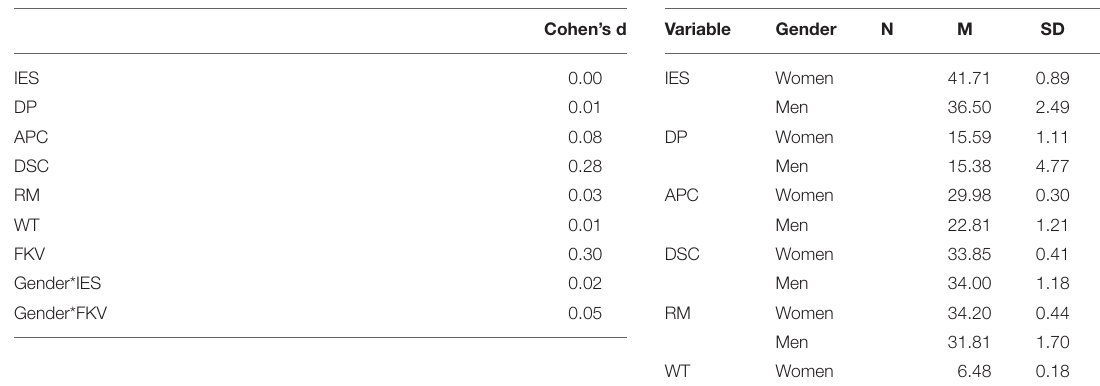
TABLE 5 | Cohen’s effect size. TABLE 6 | Independence sample T -test